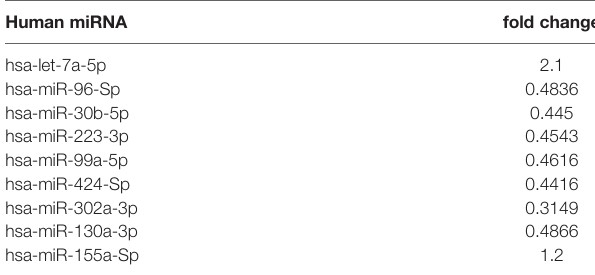
TABLE 1 | Dysregulated miRNA fold change.